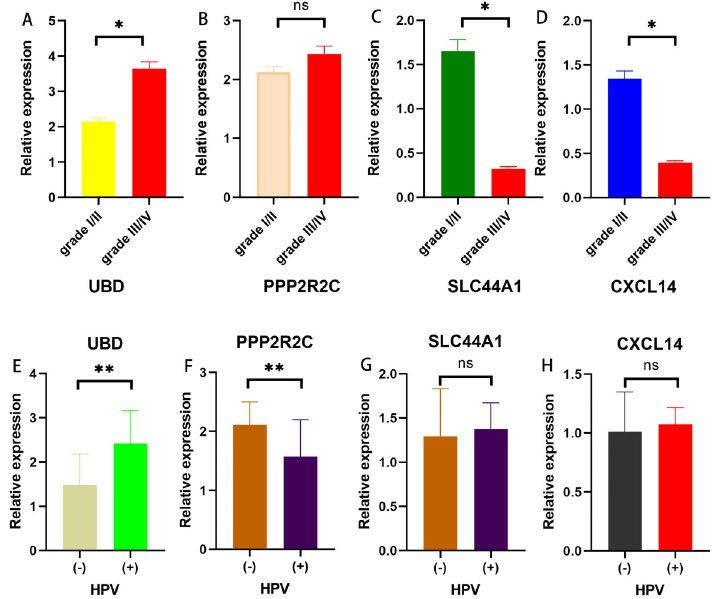
Figure 9. Four prognostic genes expression pro fi les and their correlations with human papillomavirus (HPV) status in the clinical tissue specimens. A , UBD; B , PPP2R2C; C , SLC44A1; and D , CXCL14 expression levels in the high-grade (III/IV) and low-grade (I/II) head and neck cancer (HNC). E , UBD; ( F ) PPP2R2C; ( G ) SLC44A1; and ( H ) CXCL14 expression levels in the HPV ( + ) and HPV ( – ) HNC patients. Data are reported as means ± SD. *P o 0.05, **P o 0.01 ( t -test). ns: not signi fi